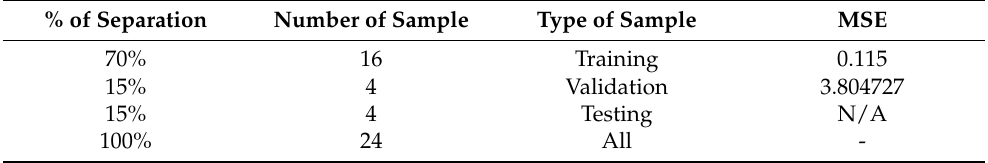
Table A6. Best performance result of the ANN model for aerobic process.